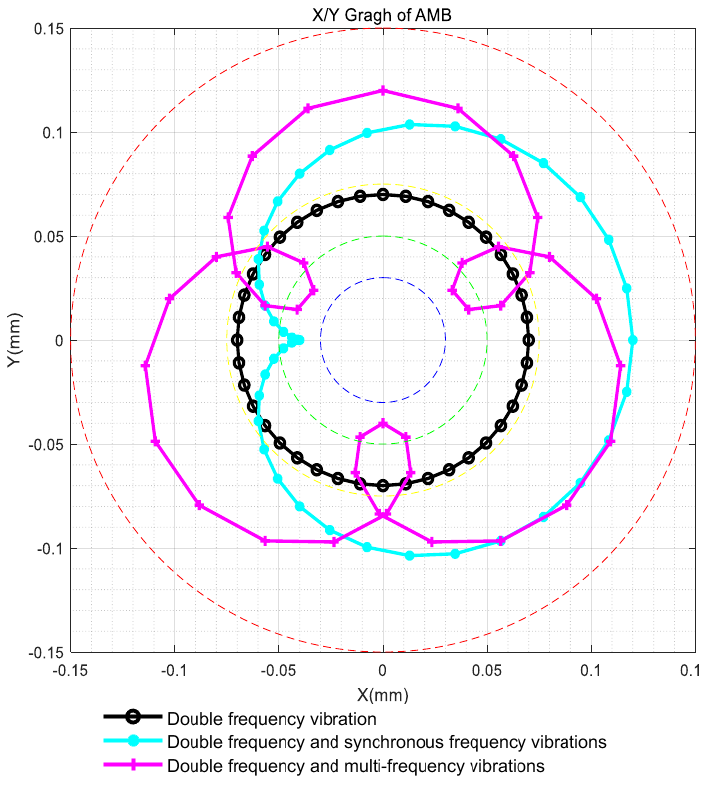
Figure 4. Several rotor's axis loci under typical combinations of vibrations.